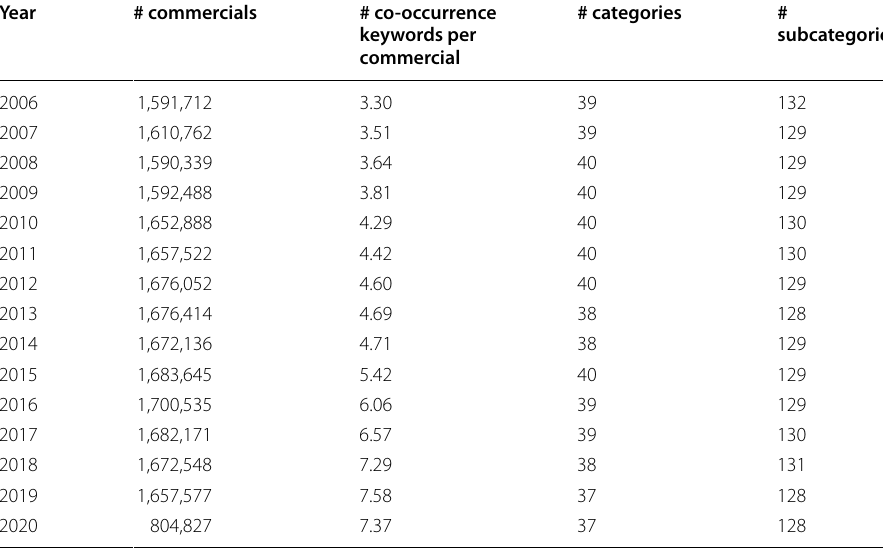
The number of commercials, the mean number of co‑occurrence keywords per commercial, and the numbers of categories and subcategories are exhibited for each year